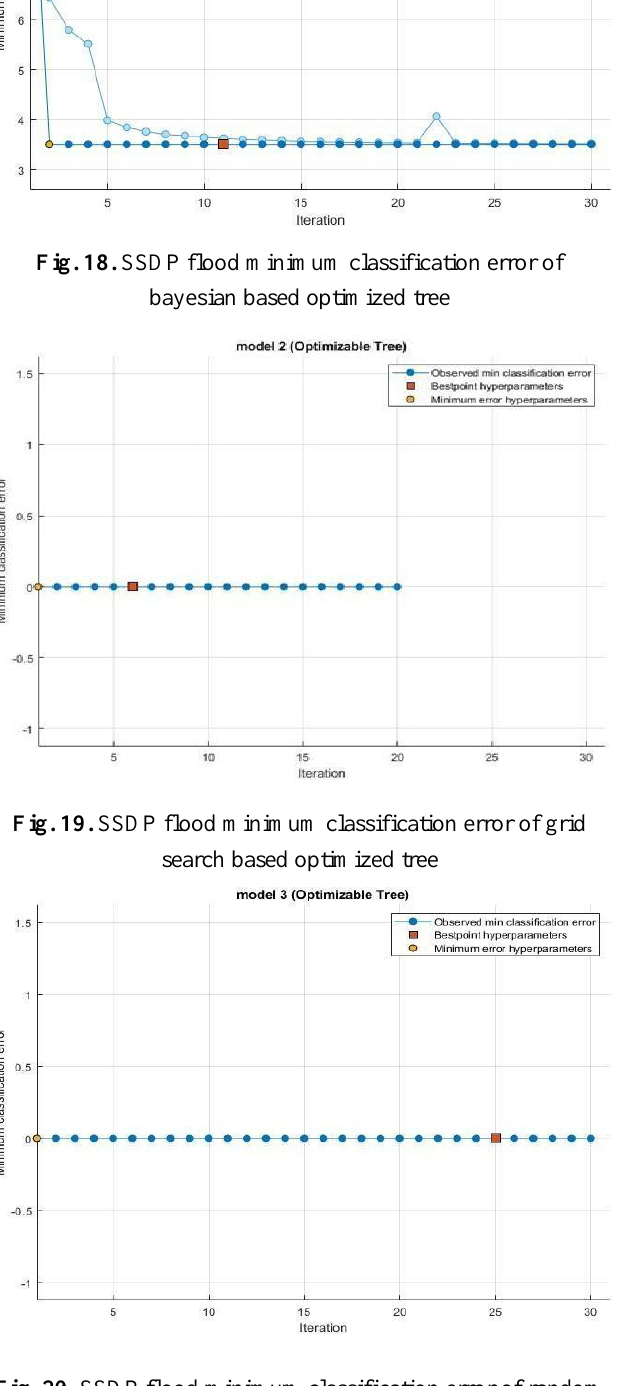
Fig. 20. SSDP flood minimum classification error of random search based optimized tree